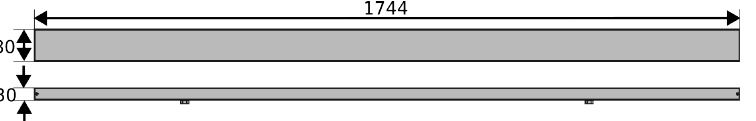
Figure 1. Scintillator in an aluminium profile 1744 × 80 × 30 mm 3